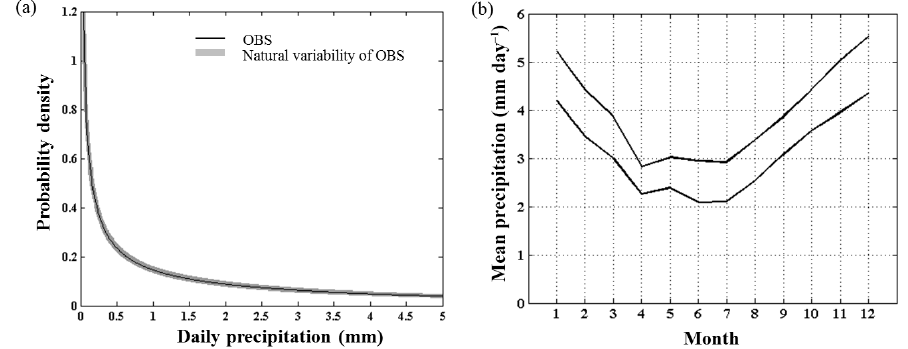
Figure 8. (a) PDFs of the observed precipitation and the resampled precipitation; (b) natural variability of monthly mean precipitation.